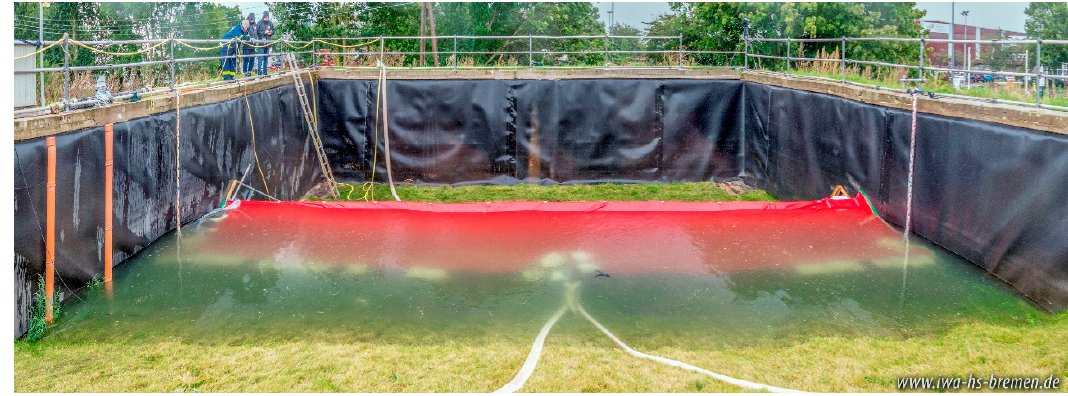
Figure 8. Overflowing SBRS—aqua defense.